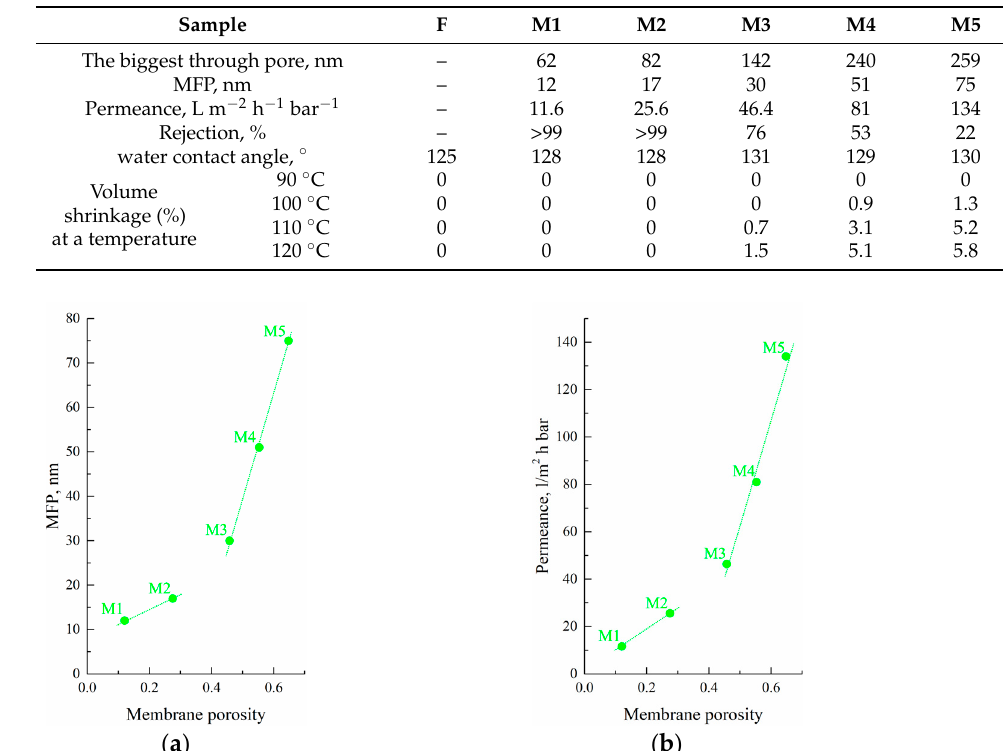
Table 4. The results of measurements of transport properties, water contact angle, and thermal stability of the initial film and membranes.